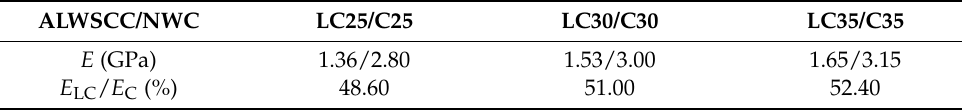
Table 6. The modulus of ALWSCC and